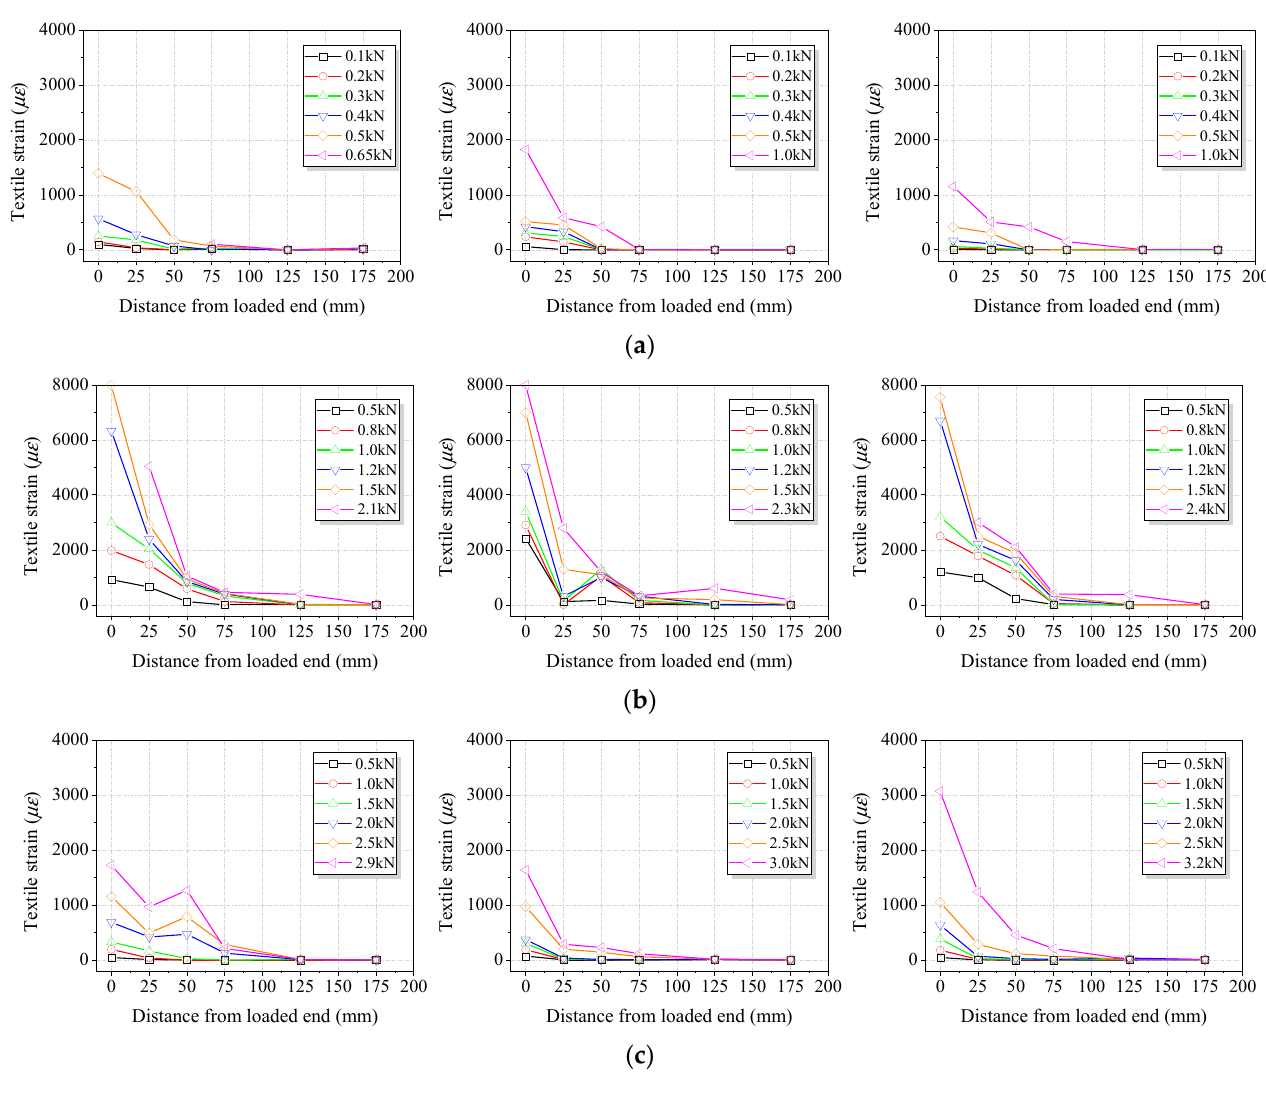
Figure 7. Basalt textile strain profiles along the bond length obtained from single shear tests. ( a ) S0. ( b ) SP. ( c ) SPI.